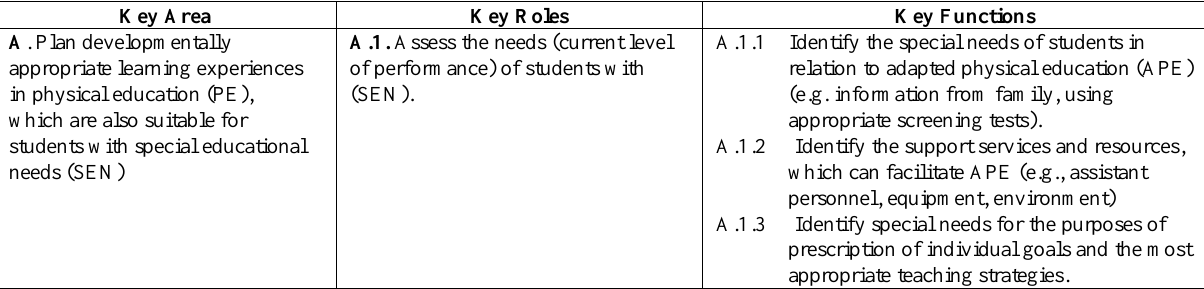
Table 2. Functional Map in Adapted Physical